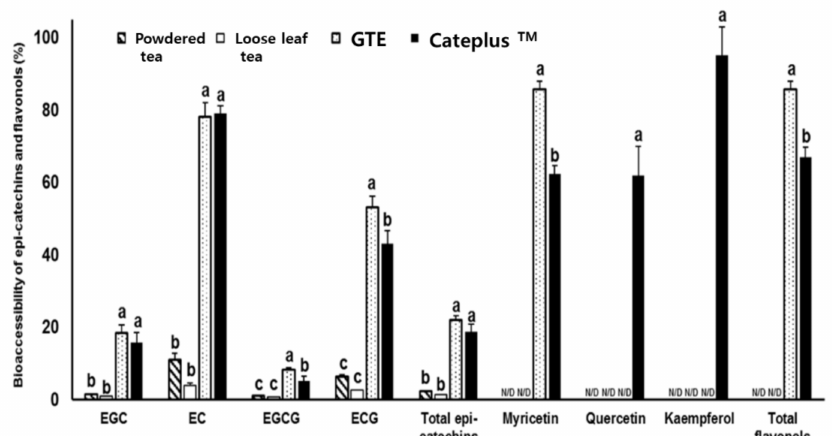
Figure 1. Bioaccessibility of epicatechins and flavonols (%). GTE: 35% catechins containing extract, CATEPLUS™: GTE formulated with green tea-derived polysaccharide and flavonols. Different letters on each bar indicate a significant difference within groups ( p < 0.05). N/D: not detected below 1 µ g/mL (EGC, EC, EGCG, ECG) or 1.25 µ g/mL (Myricetin, Quercetin,